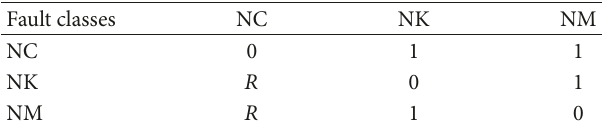
Figure 3: The structure diagram of cone-shaped check valve. Table 4: The cost matrix of check